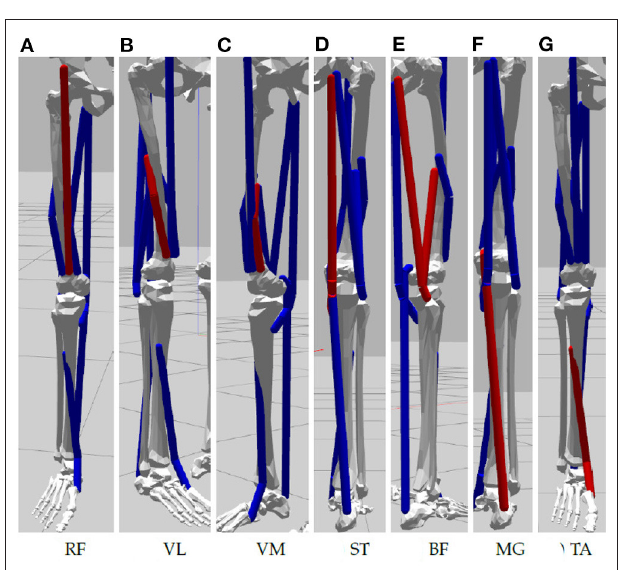
FIGURE 2 | Muscles of the simulated lower limbs considered in our experiment: (A) Rectus Femoris, (B) Vastus Lateralis, (C) Vastus Medialis, (D) Semitendinosus, (E) Biceps Femoris, (F) Medial Gastrocnemius, and (G) Tibialis Anterior.